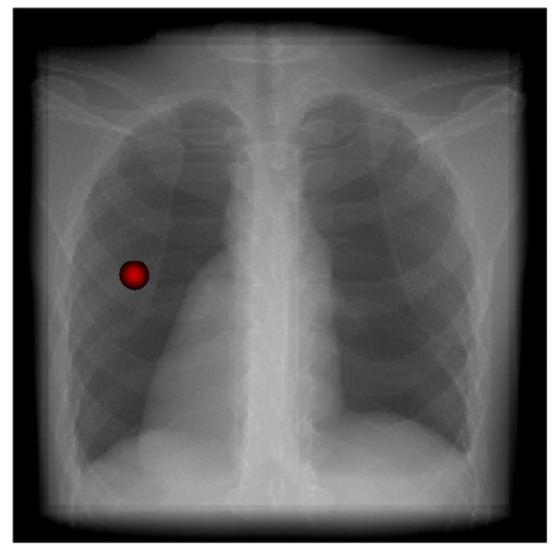
Figure 15. Dual-modal enhancement effect for pencil beam scanning